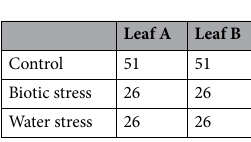
Table 7. The number of experiments in the different experimental groups.